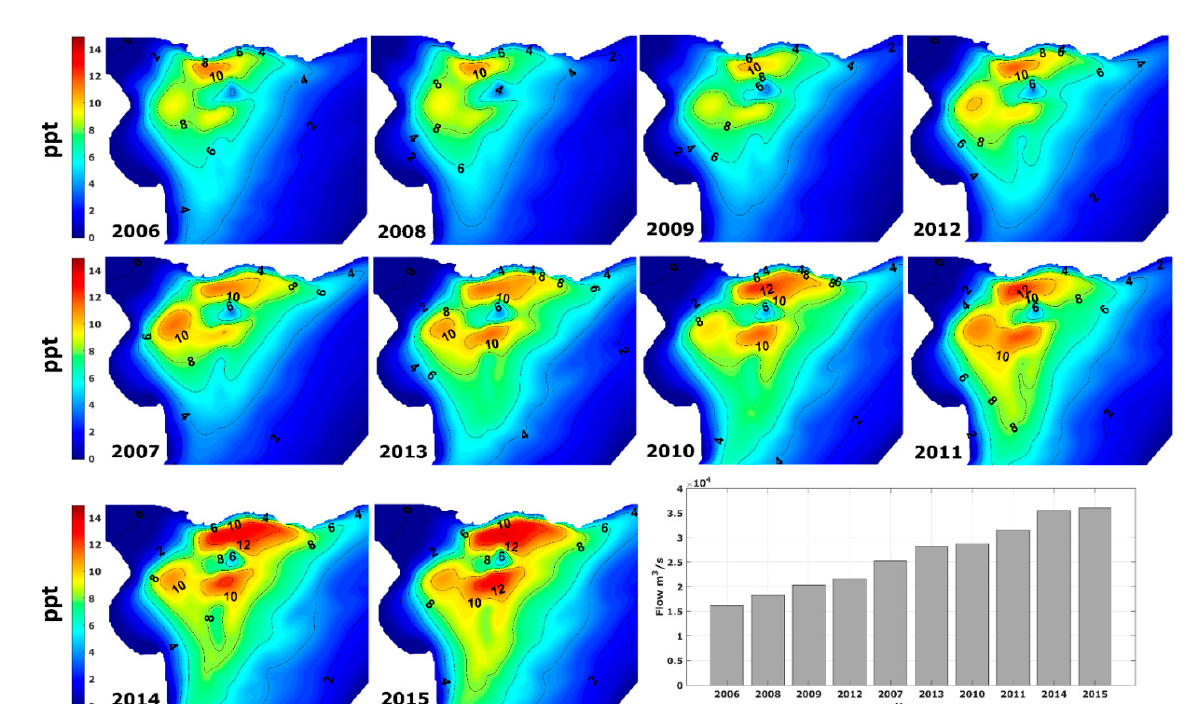
Figure 3. Annual average salinity stratification (ppt) obtained with the model for the period 2006–2015, ordered according to increasing annual mean river flow (right corner panel). All maps are in geographic coordinates between Lat ( − 36.9, − 34.7) and Long ( − 57.4, − 54.2).